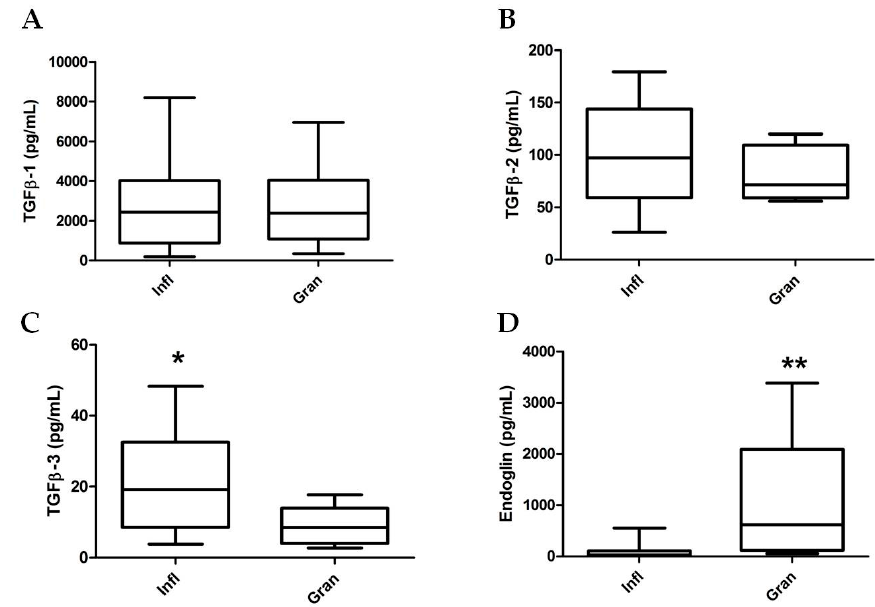
Figure 2. TGF- β isoforms and sEng levels in inflammatory and granulating wound fluids ( n = 20 and n = 10, respectively). Statistical analyses by Mann–Whitney test. ( A ) Transforming growth factor- β -1 (TGF β -1); ( B ) TGF β -2; ( C ) TGF β -3; and ( D ) soluble Endoglin concentrations in wound fluids collected